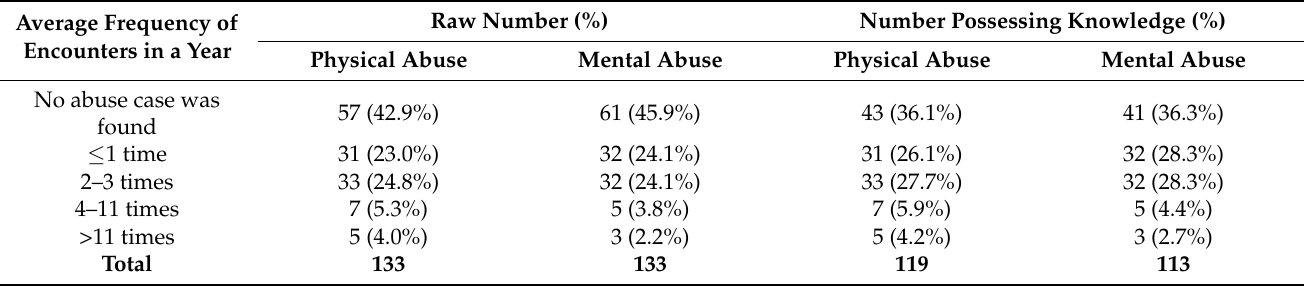
Table 9. Frequency of suspected physical and mental animal abuse cases encountered by veterinarians in the past five years in